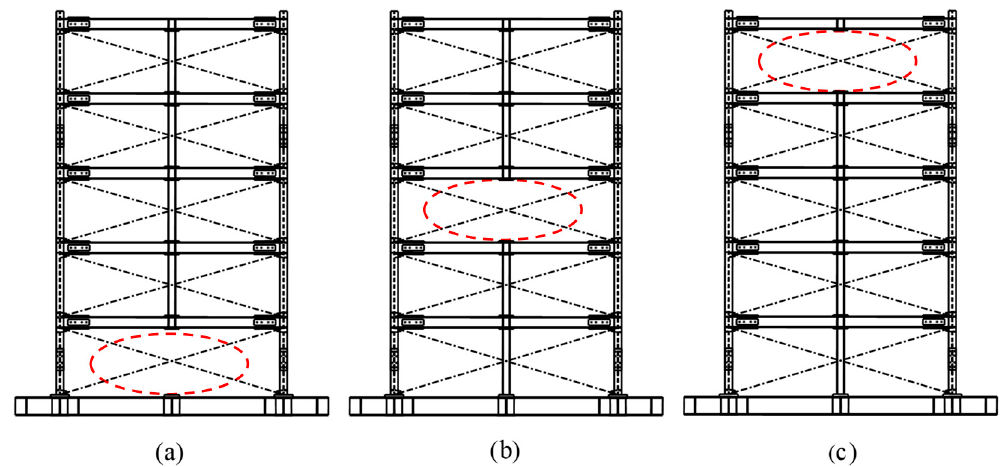
Figure 23. Damage cases: removing braces on the ( a ) first; ( b ) third; and ( c ) fifth story.